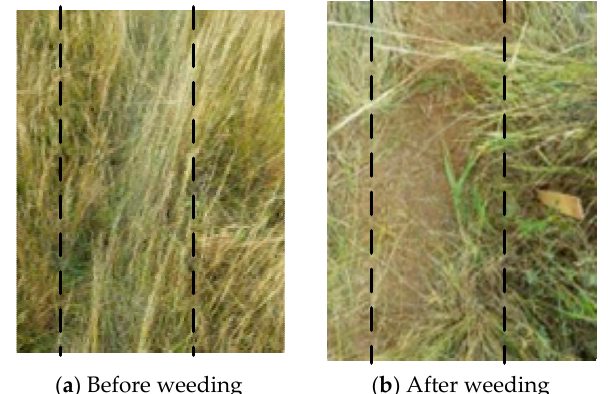
Figure 10. Contrast diagram before ( a ) and after ( b ) weeding (marking area by dotted line is weed control part).